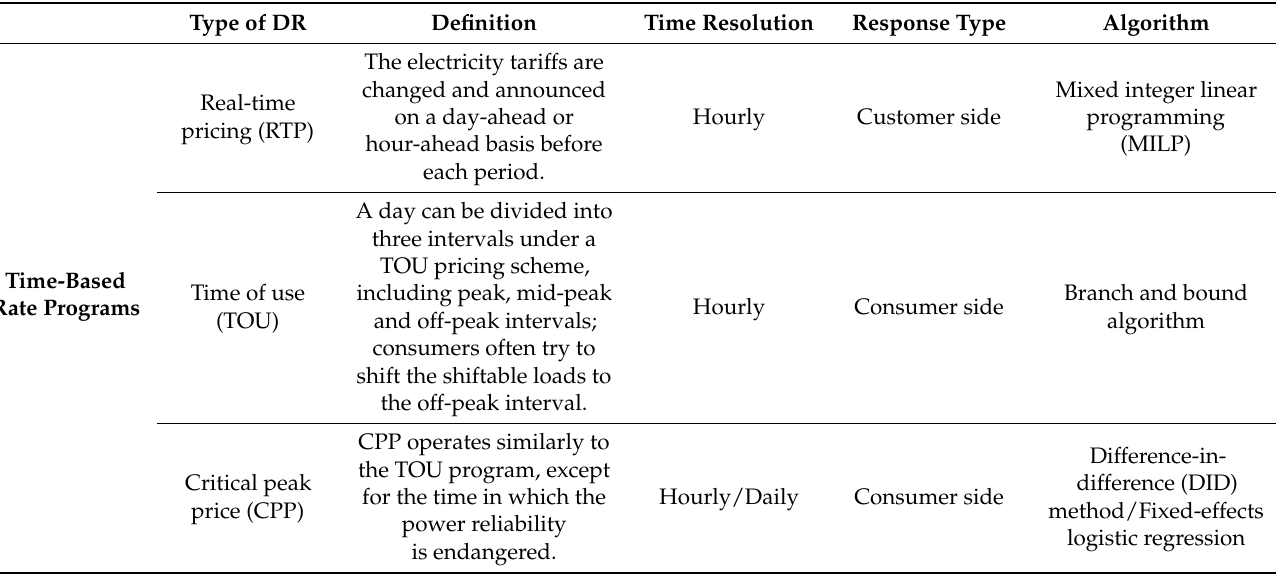
Figure 2. Classification of demand response programs (adopted from [54]). A comparison between the different DRPs based on their time resolution, response type, and methods is given in Table 1. Table 1. Comparison between different DPRs in smart